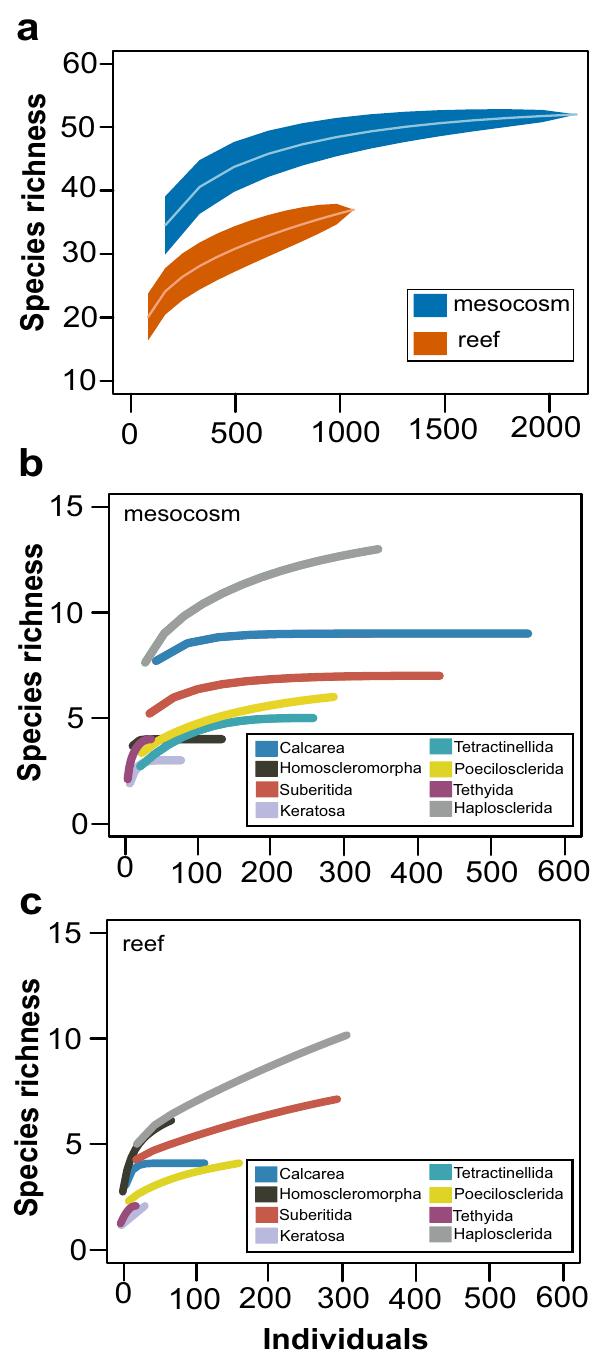
Figure 1. Species rarefraction curves of ( a ) all sponges in mesocosm and reef ARMS, and sponges separated by most abundant groups found in ( b ) mesocosm and ( c ) reef ARMS. Number of individuals refers to sponge recruits encountered at different time points based on presence/absence of sponge OTU within each side of plate from an ARMS. 95% Confidence intervals are included for rarefraction curve in ( a